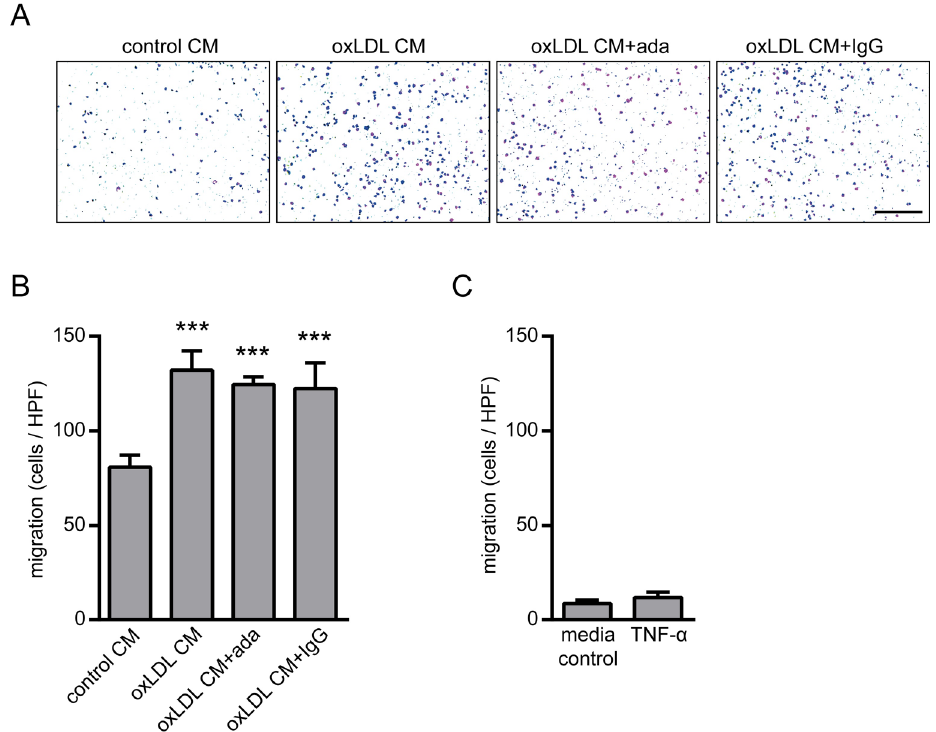
Fig 5. Effect of TNF- α inhibition with adalimumab on migration of THP-1 monocytes. (A) Images depicting crystal violet stained THP-1 cells which migrated across the membrane of transwell inserts (pore size 8 μ m) to the lower side after incubation with conditioned media from oxLDL stimulated THP-1 macrophages (oxLDL CM) with or without adalimumab (ada) for 4 hours. Representative pictures are shown. (B) Migrated cells per high power field were quantified. (C) Crystal violet stained THP-1 monocytes which migrated in response to TNF- α (10 ng/mL) across the membrane of transwell inserts (pore size 8 μ m) to the lower side were quantified per high power field. Conditioned medium from unstimulated THP-1 macrophages (control CM), IgG isotype (1 μ g/mL) and medium were used as control. Scale bar = 200 μ m. Representative pictures are shown. *** P < 0.001 vs. control CM. n = 3 – 4 replicated